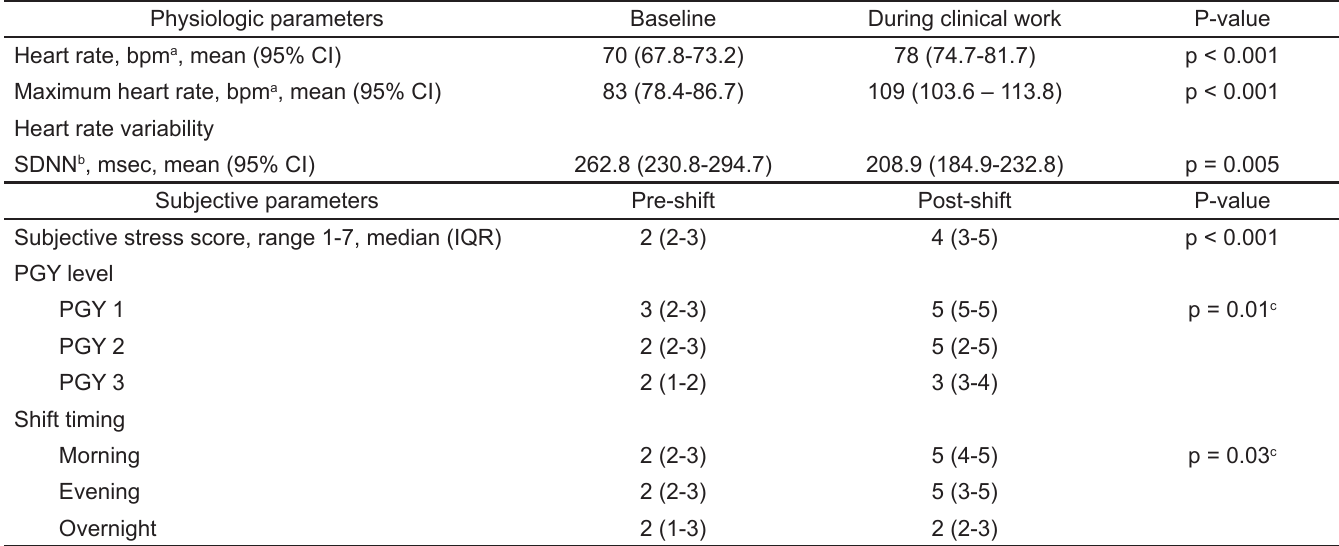
Table 2. Physiologic and subjective parameters of